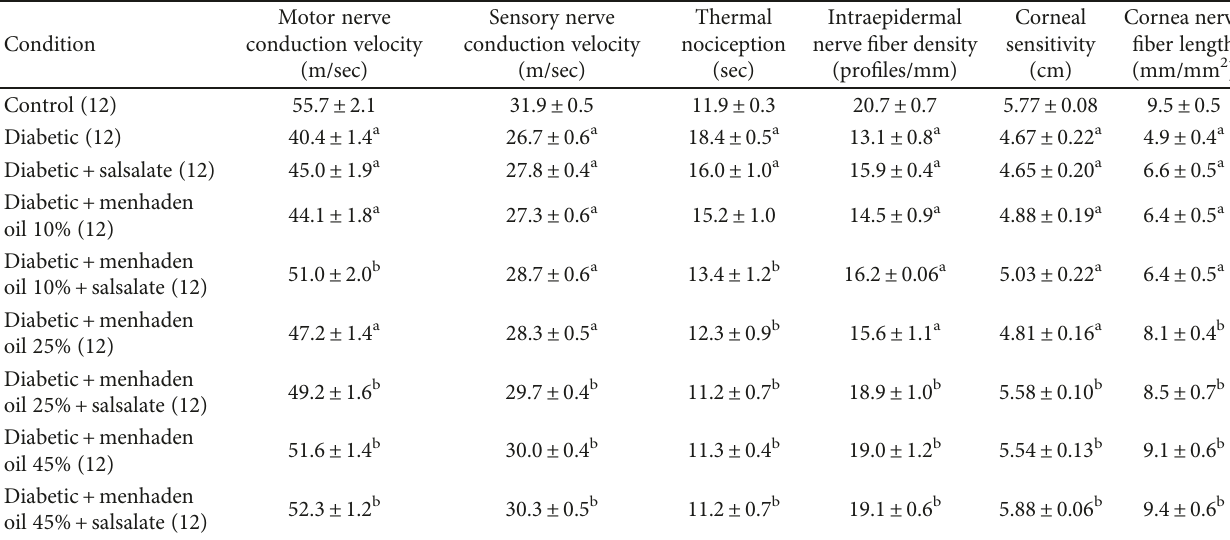
Table 2: E ff ect of menhaden oil with or without salsalate on motor and sensory nerve conduction velocity, thermal nociception, intraepidermal nerve fi ber density, corneal sensitivity, and cornea nerve fi ber length in type 2 diabetic Sprague Dawley rats. Condition